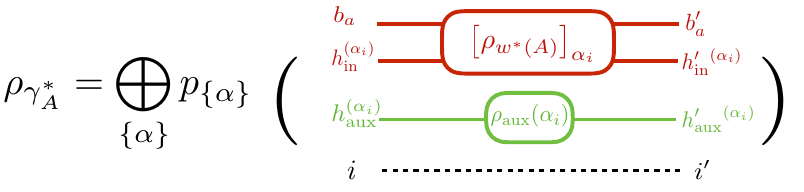
(cid:26) (cid:13) obtained by decohering the tensors G (cid:3) A (cid:11) f g refers to the subspace of ( H in ) L at link i (cid:2) (cid:3) in